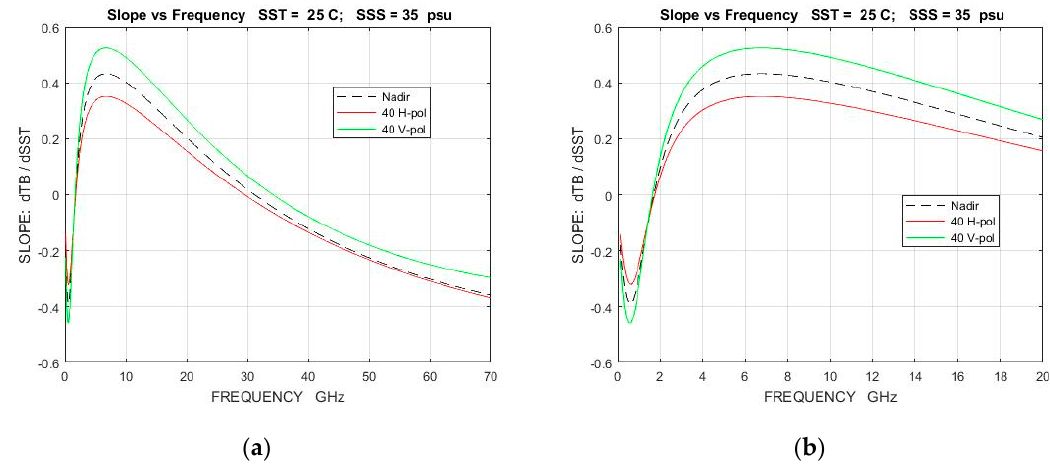
Figure 6. Sensitivity of brightness temperature to changes in temperature, SST, as a function of frequency for SSS = 35 psu and SST = 25 ℃ . Dashed line at nadir and solid line at 40 ° incidence angle. These figures are for a flat surface and use the Klein-Swift [19] model function. Figure 6b is the same as Figure 6a with expanded frequency scale to show the behavior at low frequency.